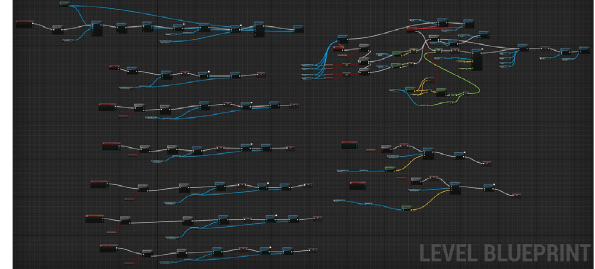
Figure 10. Level Blueprint of the narrative